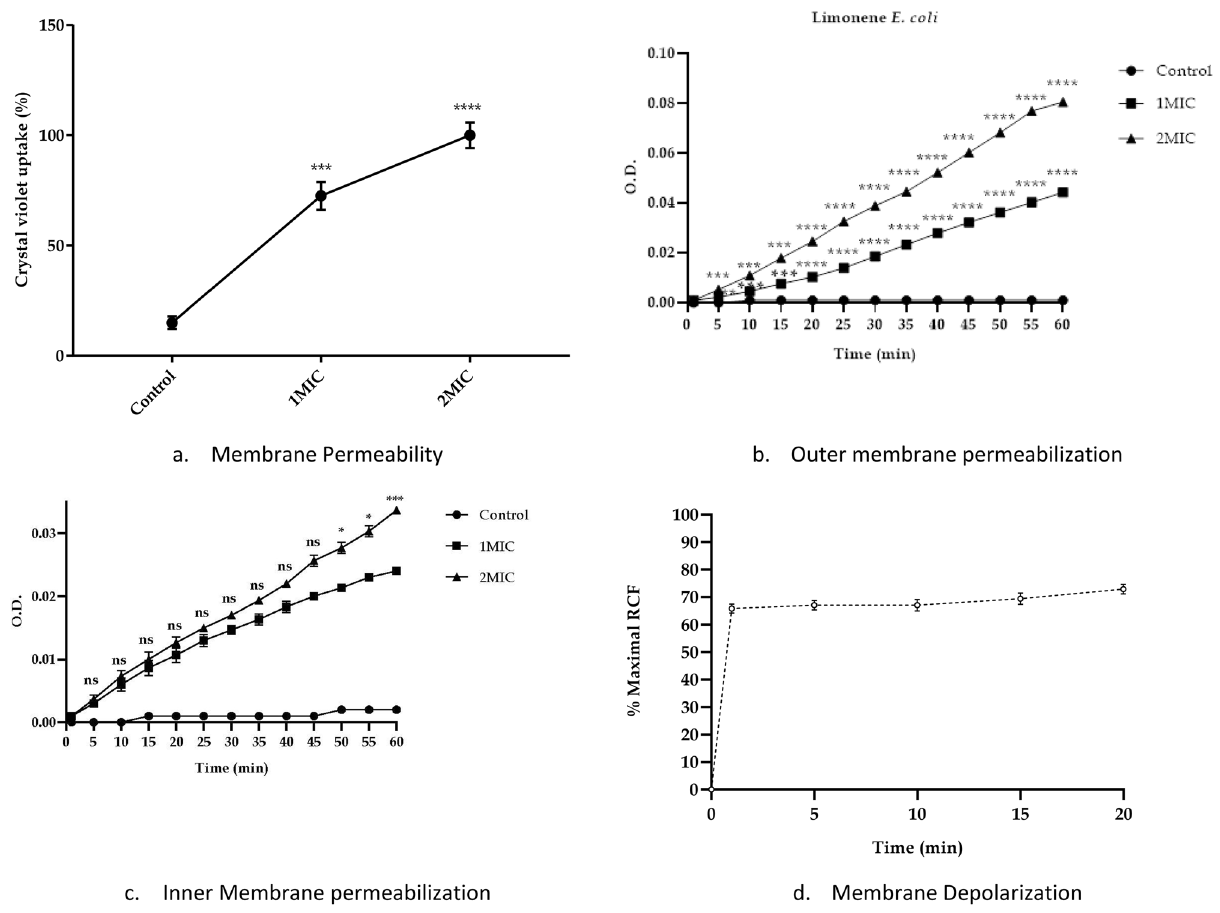
Figure 5. Effect of limonene on ( a ) membrane permeability, ( b ) outer membrane permeabilization, ( c ) inner membrane permeabilization, ( d ) membrane depolarization in Escherichia coli [****P ≤ 0.0001; ***P ≤ 0.001; **P ≤ 0.01; *P ≤